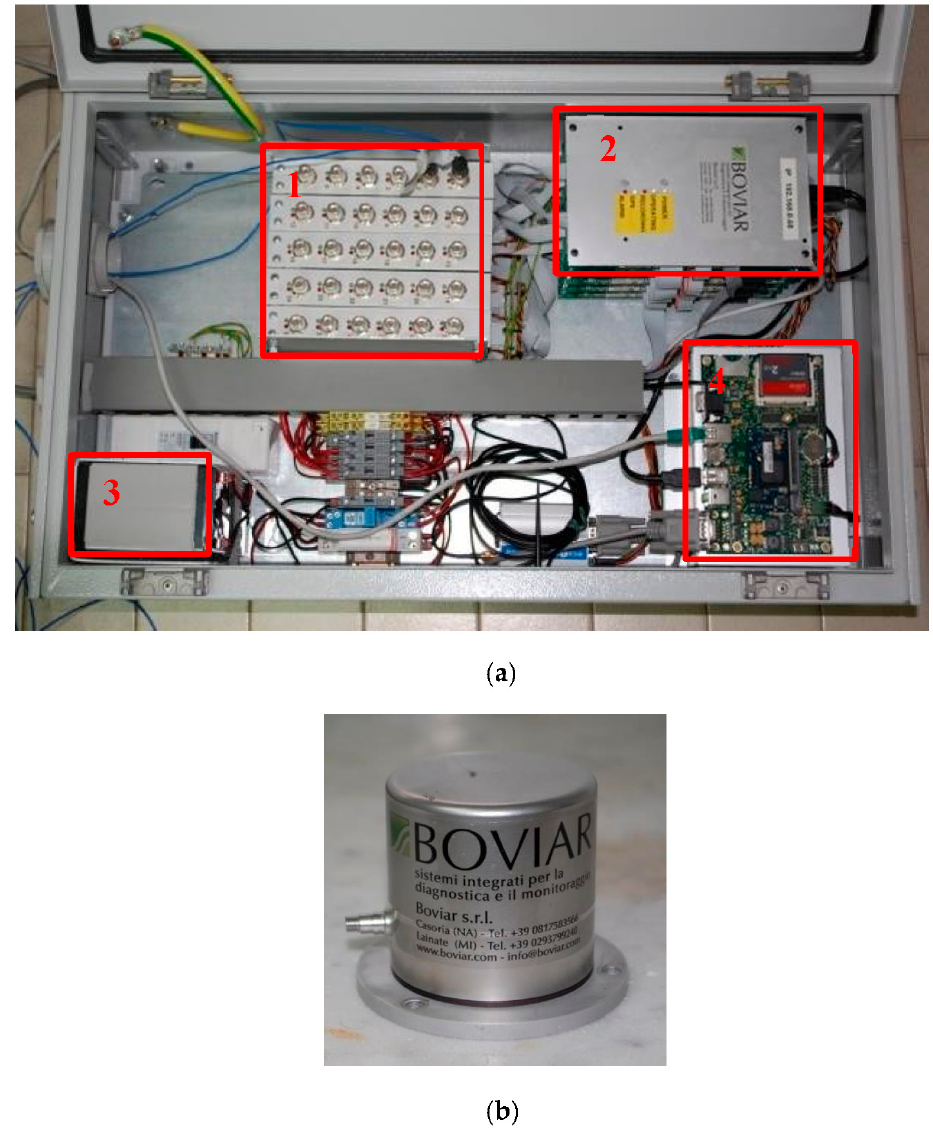
Figure 1. ( a ) Data acquisition hardware Dymas 24. It is composed of 30 channels (1) managed by 5 acquisition cards (2), an internal battery, (3) and a central unit with CPU that has the task of managing the acquisition process, synchronization of the sensors, and data storage (4); ( b ) PCB 393 C